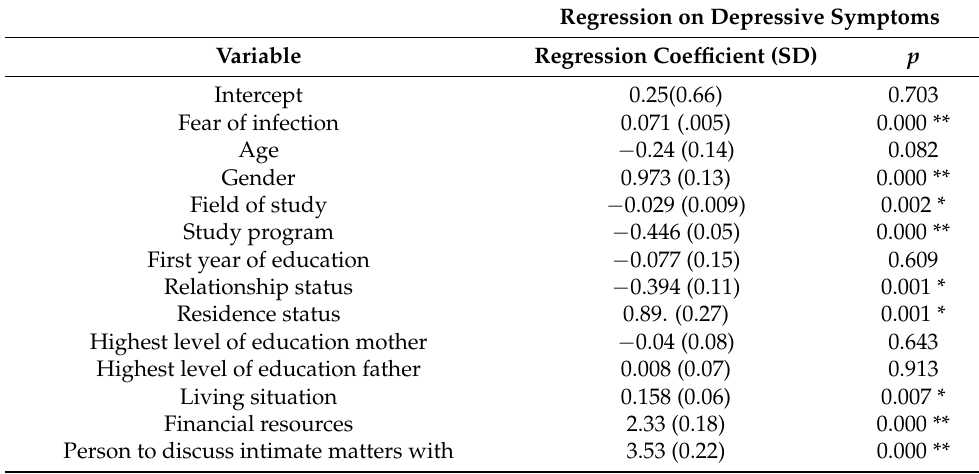
Table 4. Regression on depressive symptoms with the predictor fear of infection with